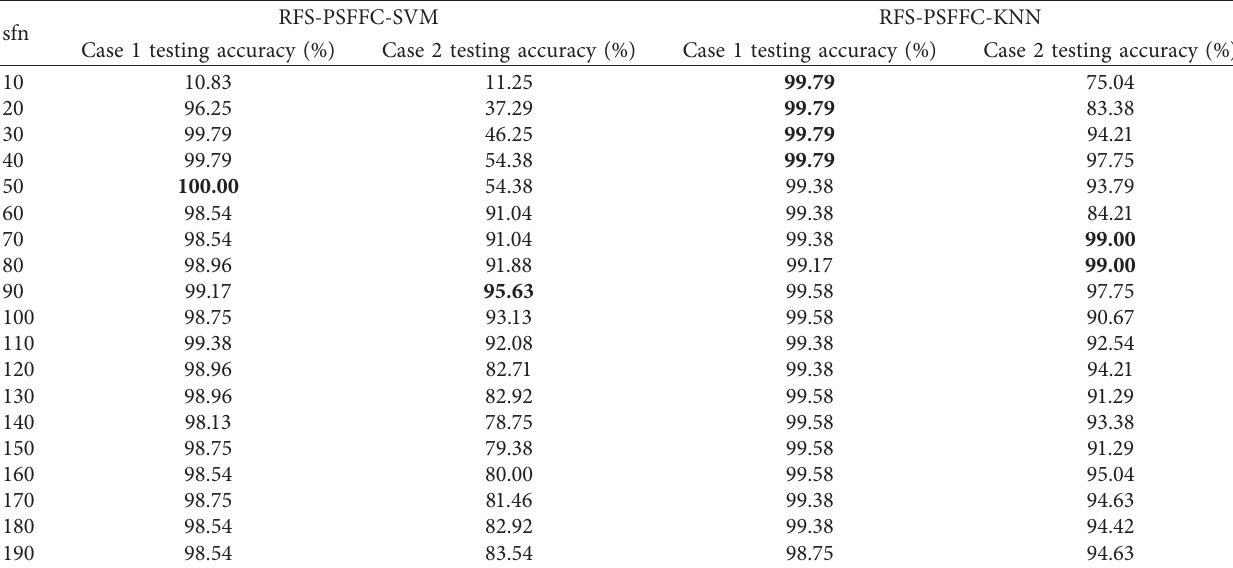
Table 9: Testing accuracies obtained by RFS-PSFFC-SVM and RFS-PSFFC-KNN. RFS-PSFFC-SVM RFS-PSFFC-KNN sfn Case 1 testing accuracy (%)